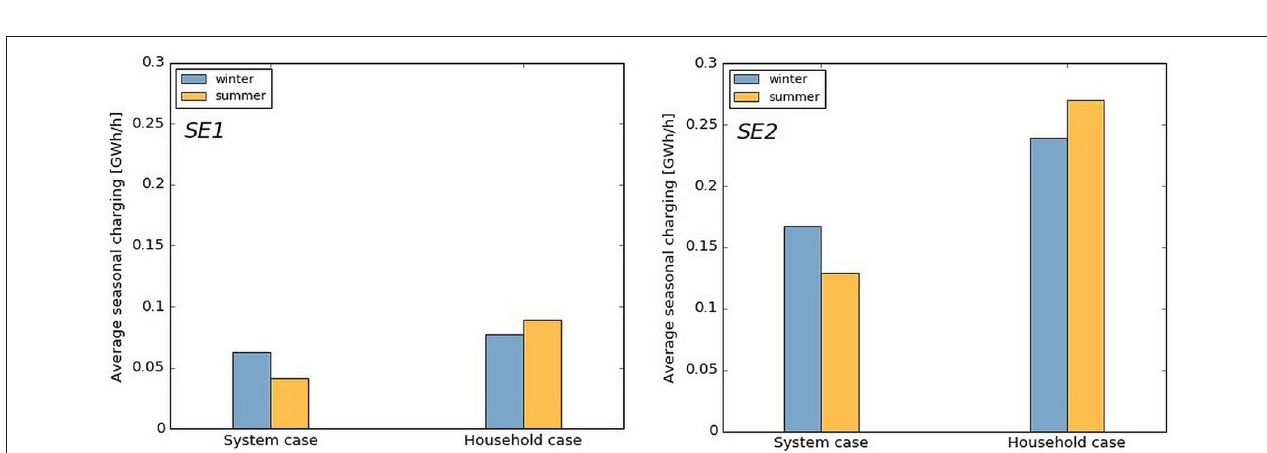
FIGURE 8 | Dispatch for system and household optimization in SE2 for two summer weeks in Year 2032, as derived from the modeling in this work, for (A) the System case and (B) the Household case in the Green Policy scenario.